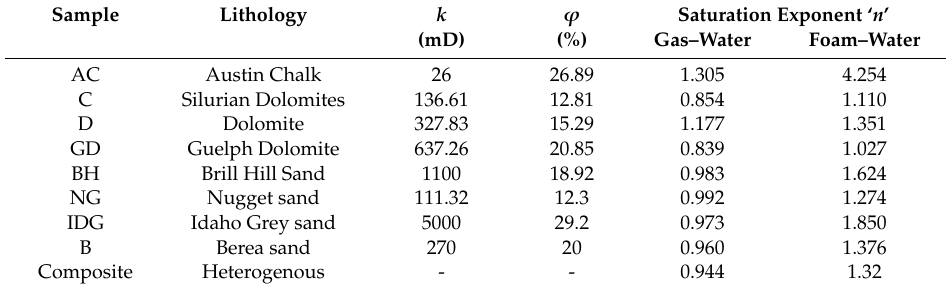
Table 1. Saturation exponents for gas–water and foamed gas–water in di ff erent rock samples.